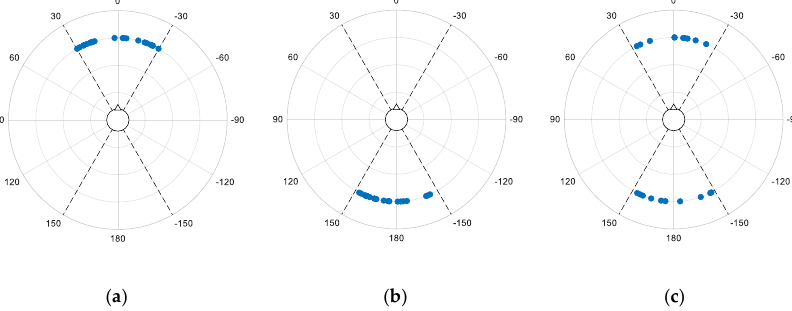
Figure 2. Examples of an intended placement of 20 foreground audio objects for: ( a ) FB scene; ( b ) BF scene; ( c ) FF scene.